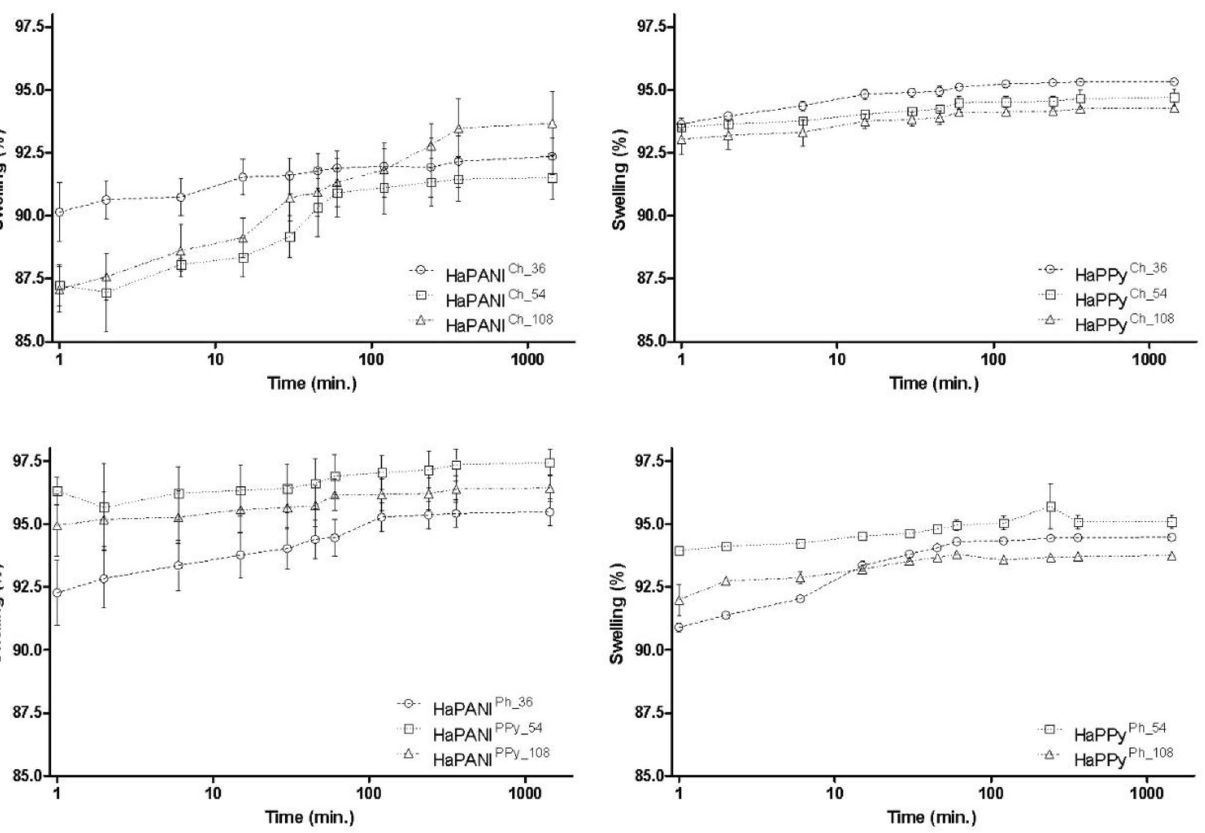
Figure 6. Swelling behaviour, expressed as average swelling degree. The average values from four measurements reported with standard